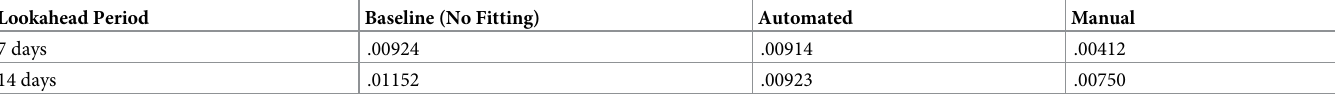
Table 3. RMSLE for the forecast periods of 7 and 14